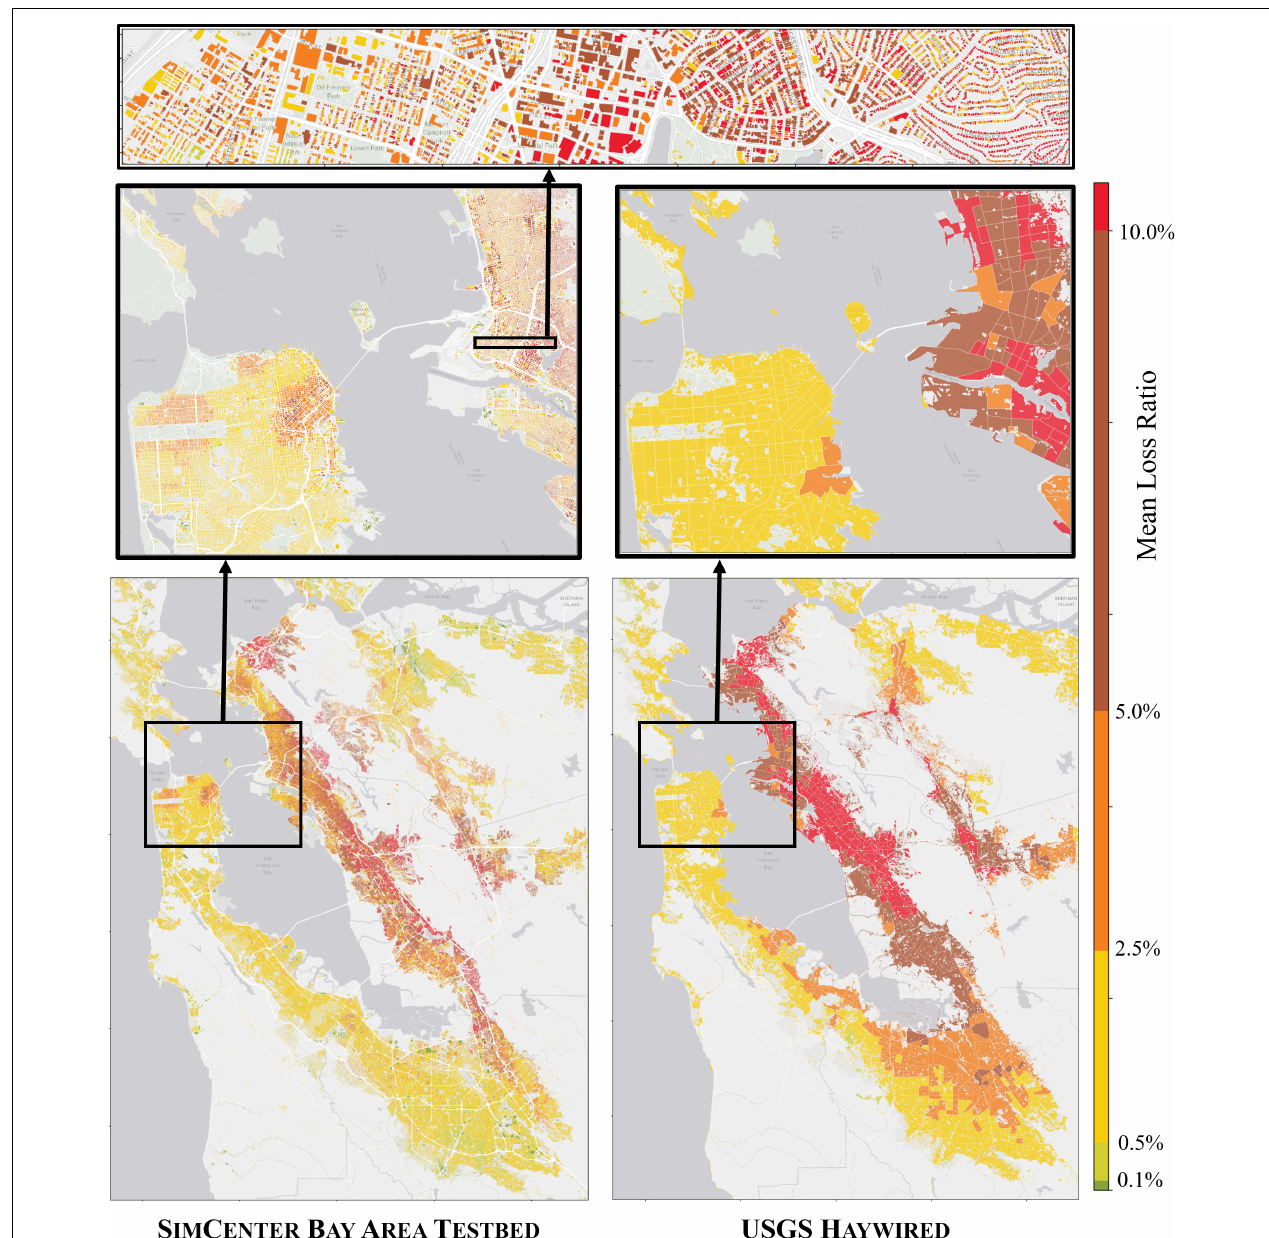
FIGURE 6 | Comparison of building loss ratios from San Francisco testbed—SimCenter (left) , USGS-Haywired (right)